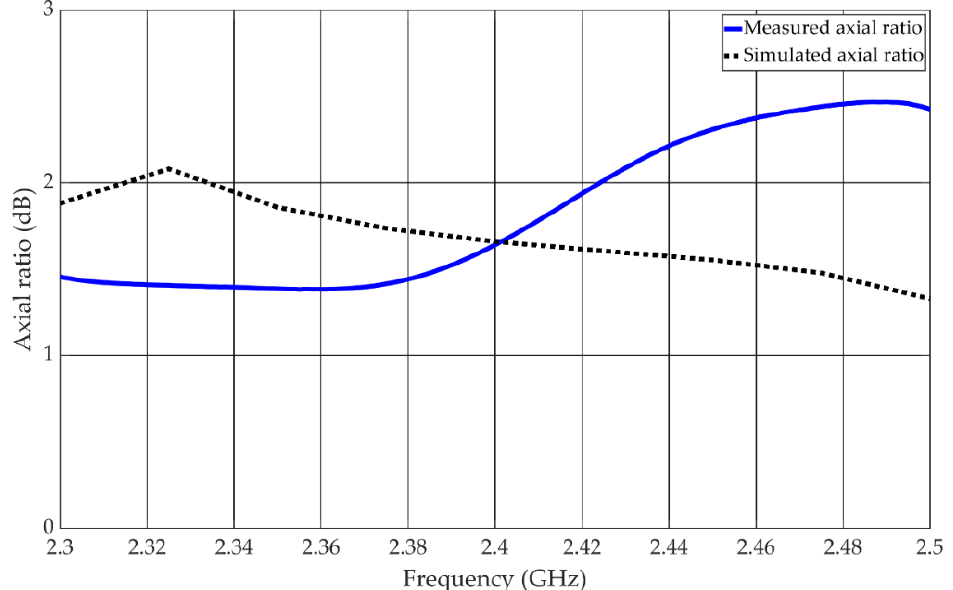
Figure 8. Axial ratio of the antenna in circular state.